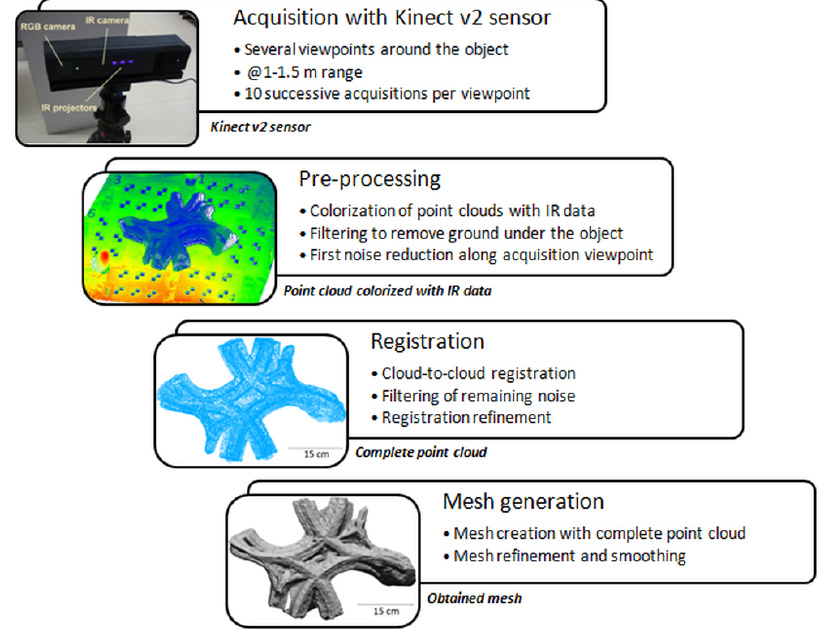
Figure 11. Processing chain applied in this study for 3D reconstruction based on Kinect, from the acquisition of point clouds to the mesh